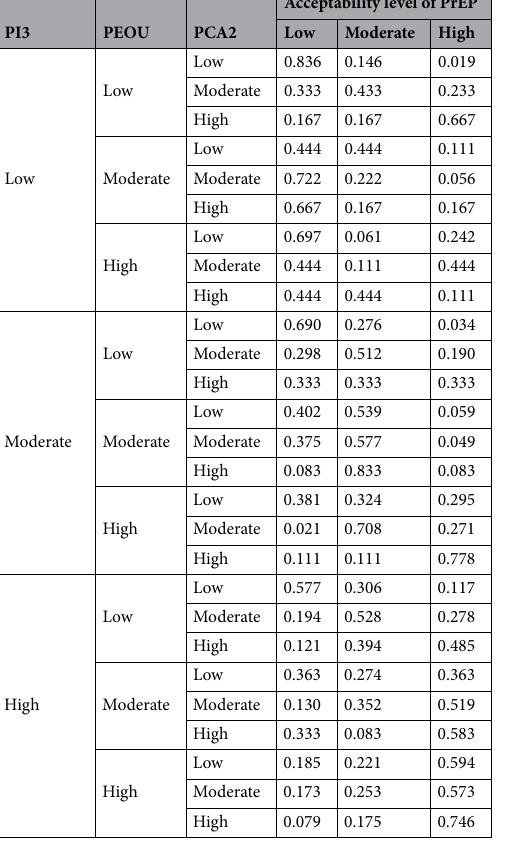
Table 5. Conditional probability table of acceptability of PrEP. PrEP pre-exposure prophylaxis, PI3 perceived image of user as health-conscious, PEOU perceived ease of use, PCA2 perceived comparative advantage of having sex when the urge